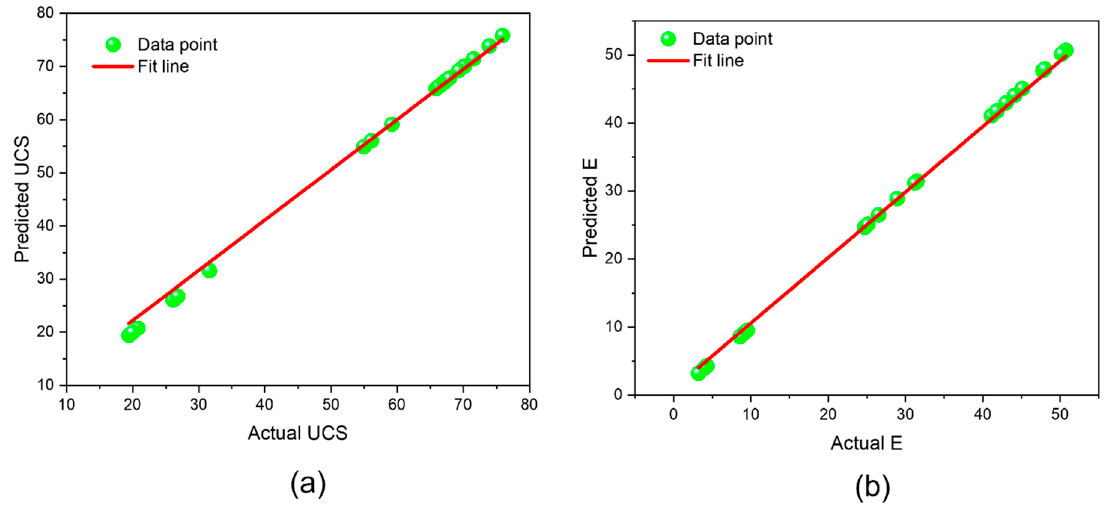
Figure 11. Relationship between the predicted and actual UCS ( a ) and E ( b ) using ANN approach. Table 5. Relation between the actual and the predicted values of UCS and E for used intelligent The MSE (mean squared error) metric was used to assess network accuracy and effi- ciency. Increasing the neuron count in the hidden layer reduced the MSE value as the number of iterations rose. The MSE for each UCS and E model was assessed. A lower MSE number at 11 epochs for UCS and E resulted in the best regression model, as illustrated in Figure 12.